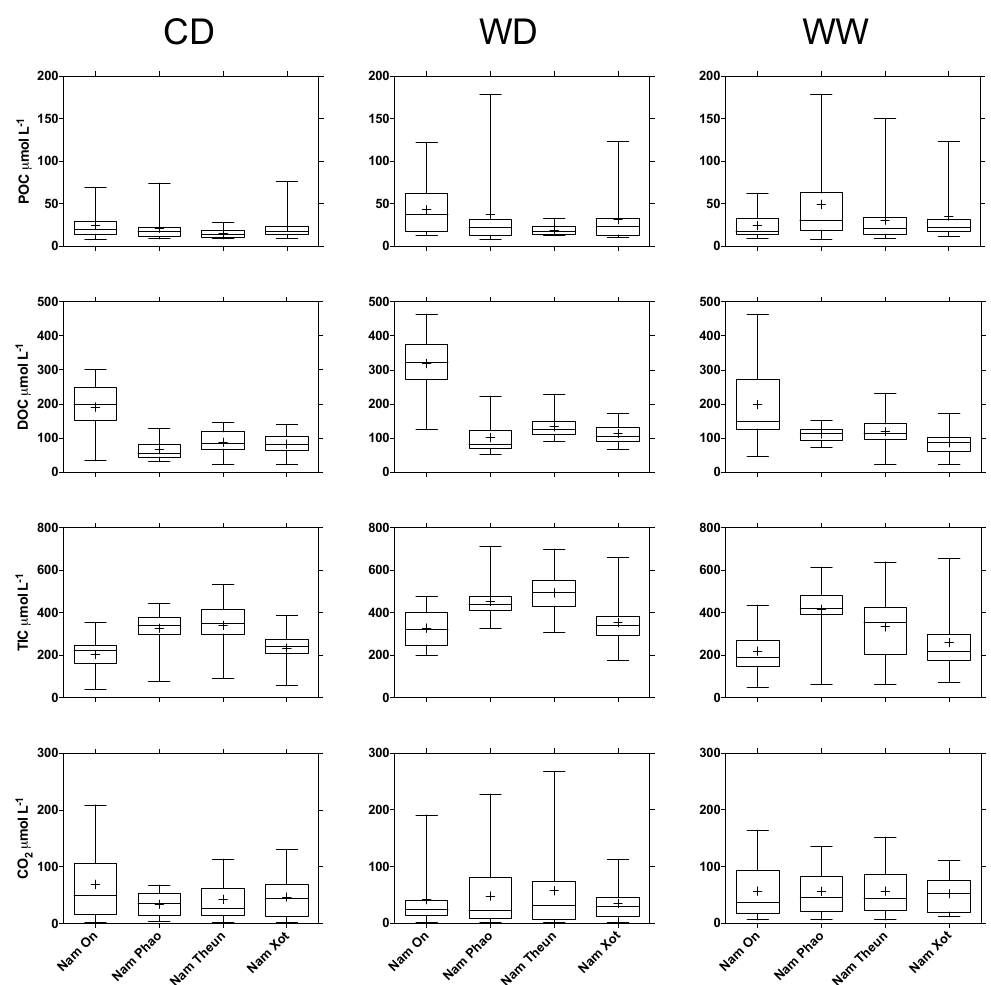
Figure 2. Median and interquartile ranges (boxes), average ( + ), and full range of values (whiskers) of particulate organic carbon (POC), dissolved organic carbon (DOC), total inorganic carbon (TIC) and CO 2 concentrations in four pristine rivers of the Nam Theun watershed during three distinct seasons: cold dry (CD), warm dry (WD) and warm wet (WW) seasons. The dataset includes data from 2009 to